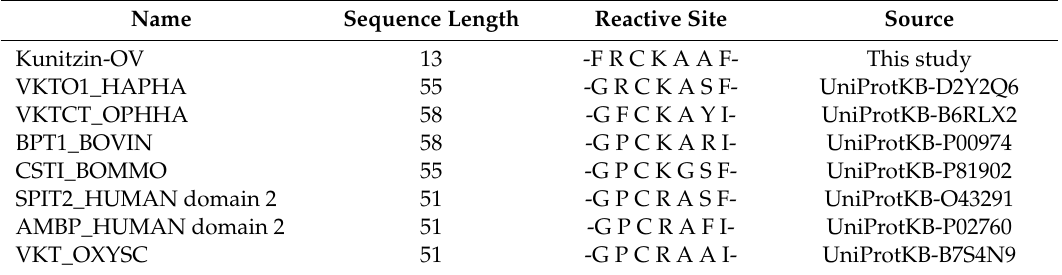
Table 3. Comparison of the reactive sites of Kunitzin-OV with di ff erent kinds of Kunitz-type protease inhibitors. The reactive sites are